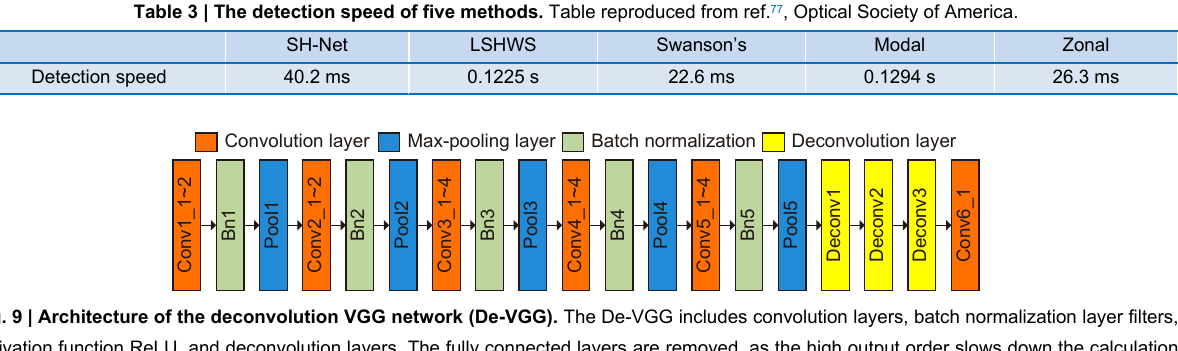
Table 3 | The detection speed of five methods. Table reproduced from ref. 77 , Optical Society of America.